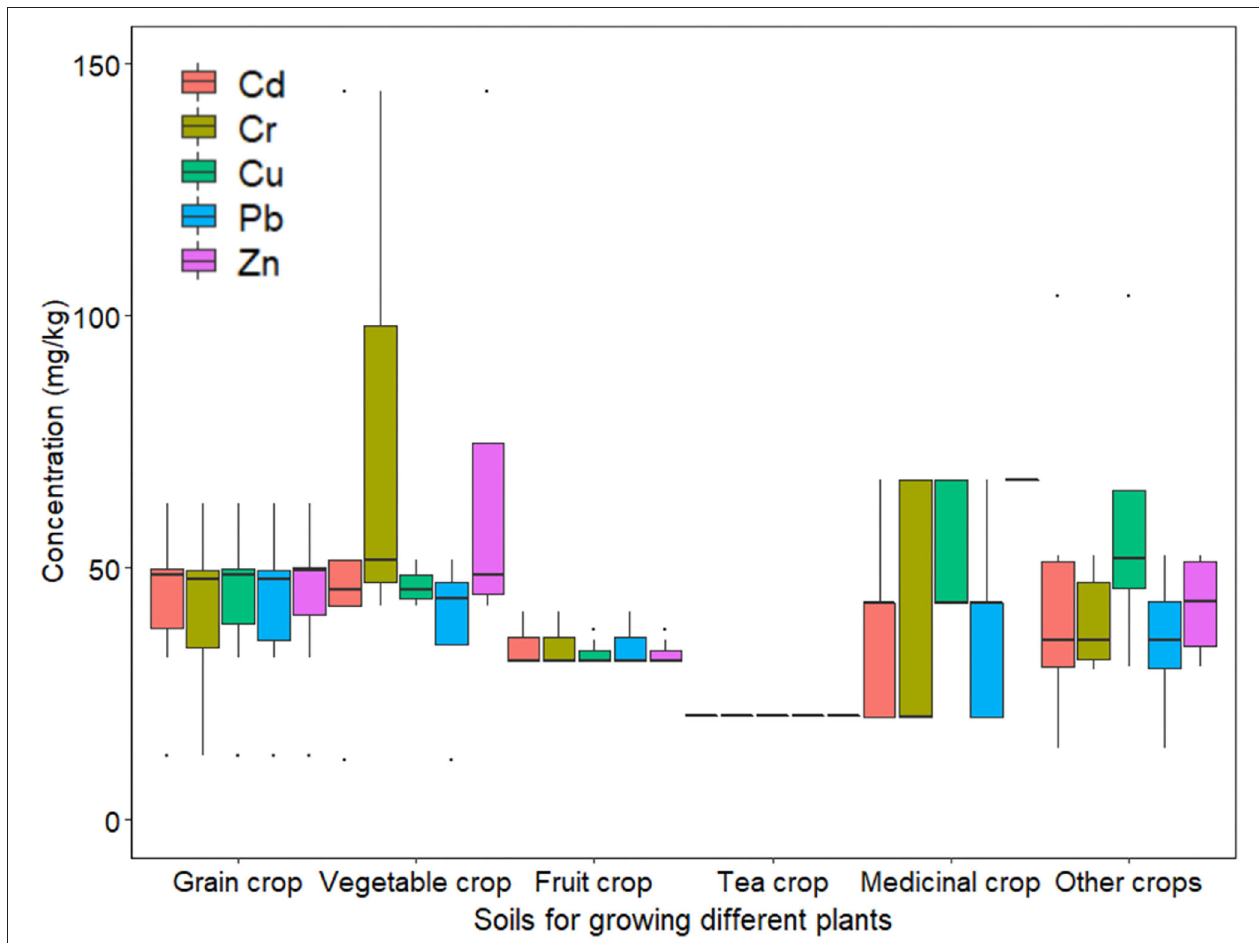
FIGURE 5 | The heavy metal concentration in soil for growing different